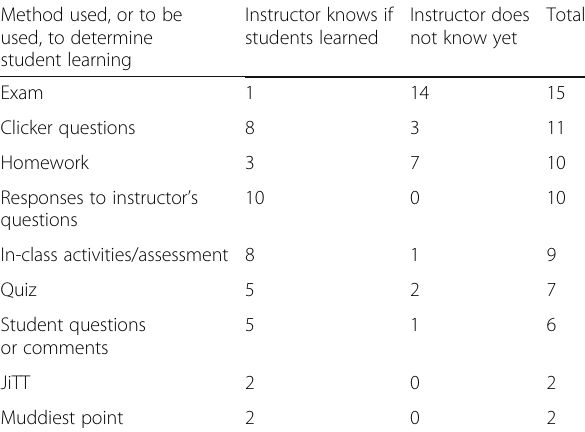
Table 2 Methods used to determine student learning Method used, or to be used, to determine student